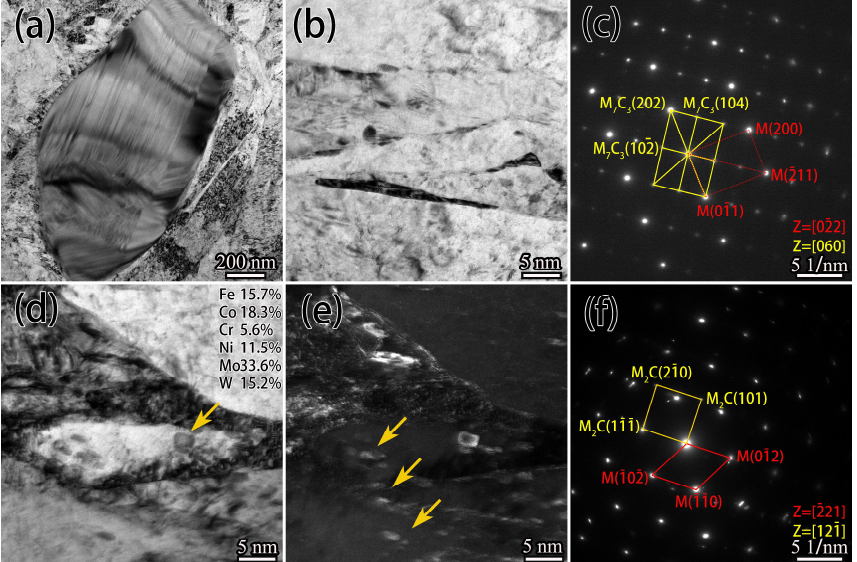
Figure 11. Carbides at 0.1 mm in the surface layer under L2 process: ( a , b ) M 7 C 3 -type carbide; ( c ) calibration of ( b , d ) bright-field image of M 2 C; ( e ) dark-field image of M 2 C; ( f ) calibration of M 2 C.